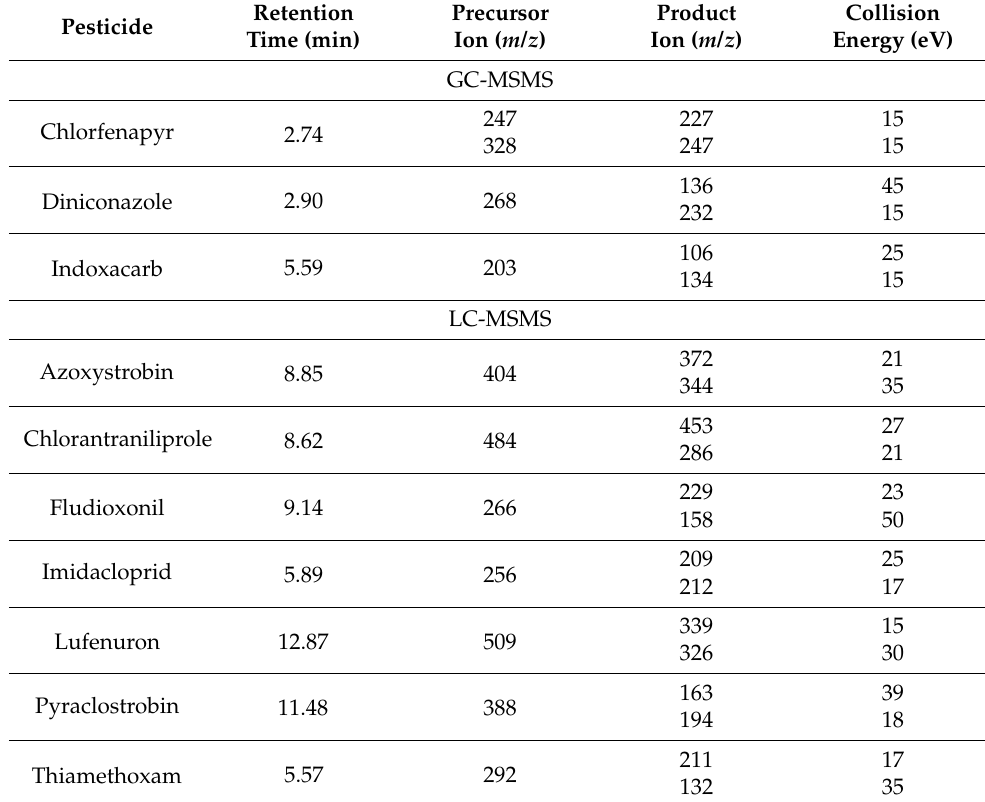
Retention Time (min)